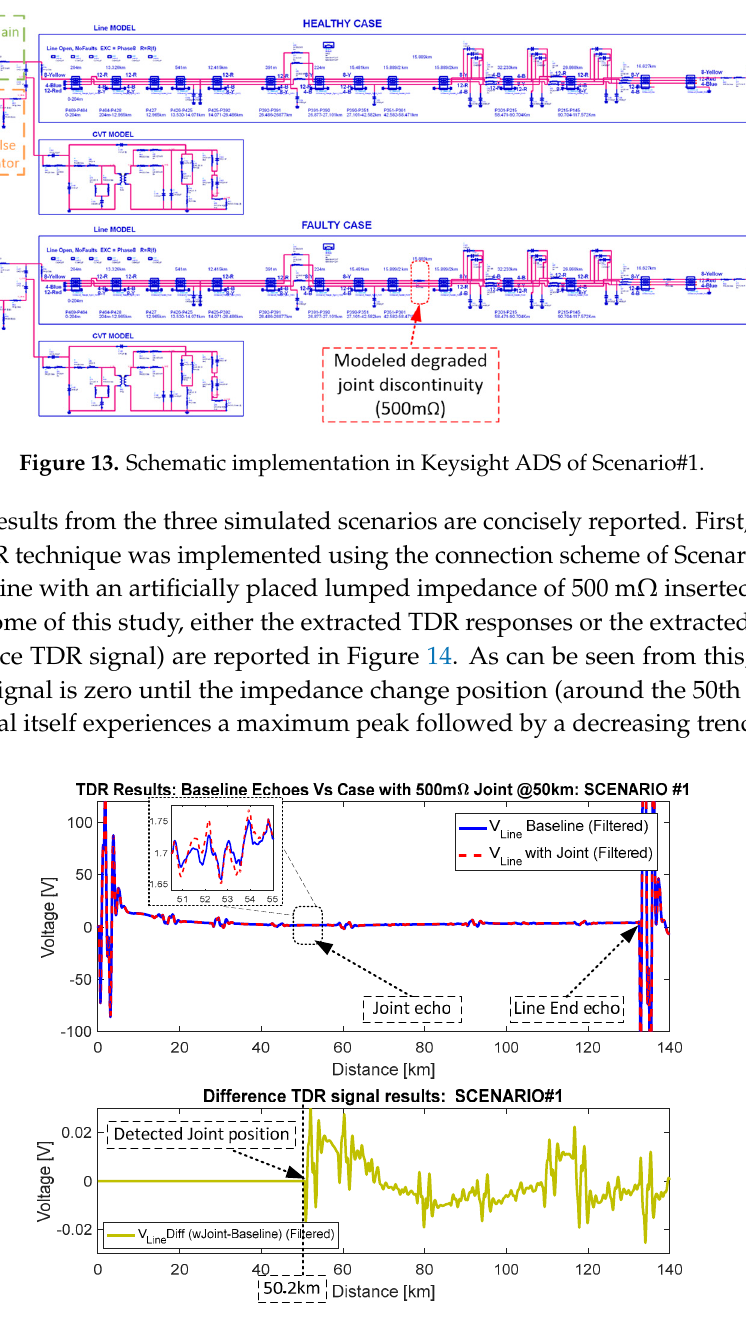
Figure 14. Extracted TDR response and difference TDR signal for fault-detection purposes when using the injection/measurement connections of Scenario#1.